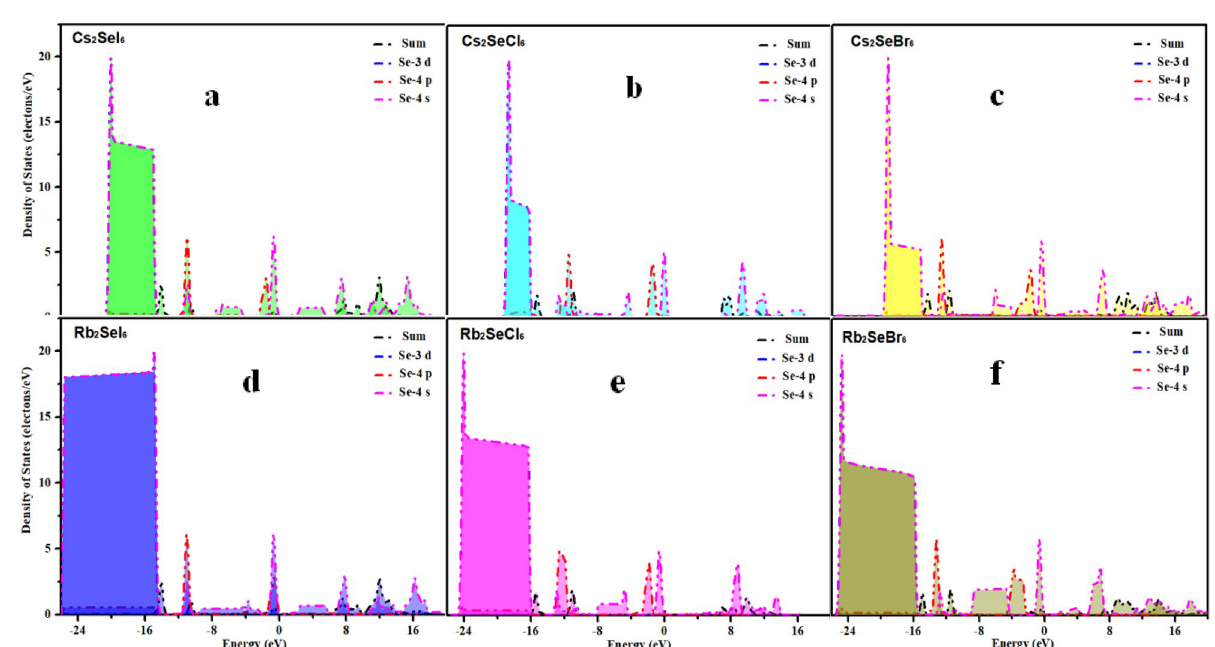
Figure 13. PDOS curves of Se-containing perovskite materials ( a ) Cs 2 SeI 6 ( b ) Cs 2 SeCl 6 ( c ) Cs 2 SeBr 6 ( d ) Rb 2 SeI 6 ( e )